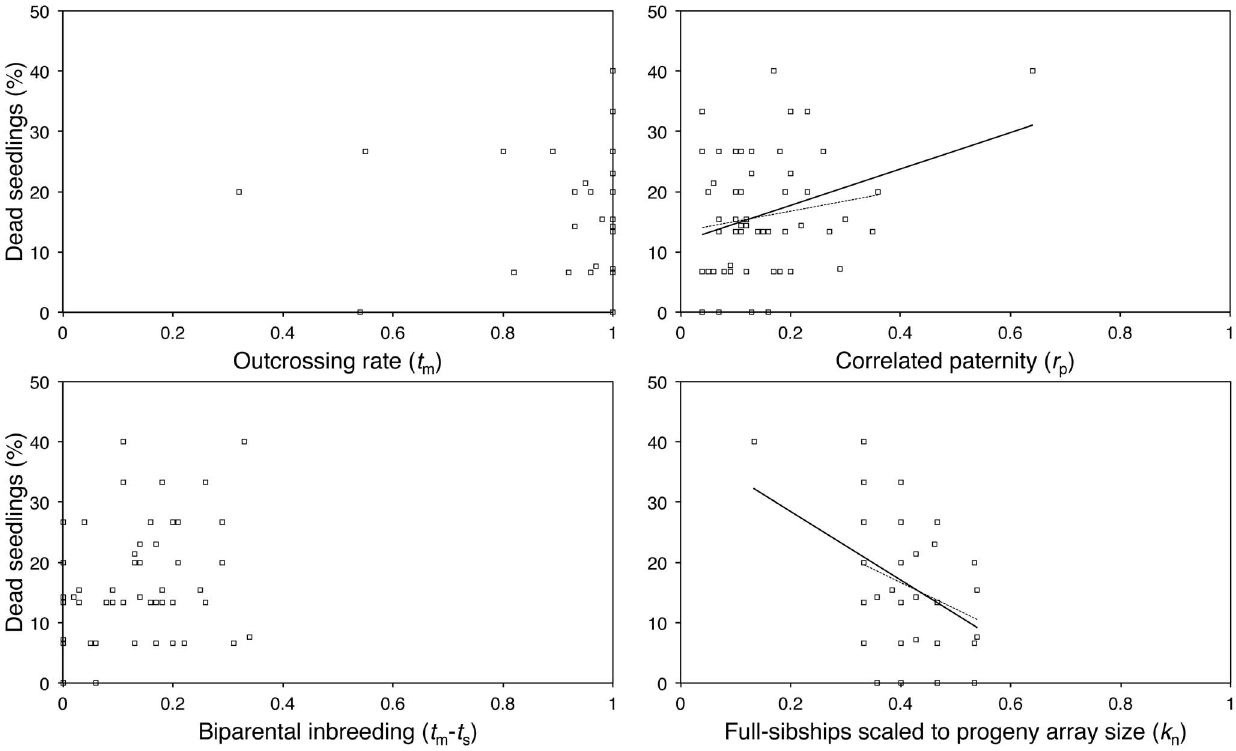
Figure 2. Scatterplots showing relationships between Eucalyptus gracilis family-level establishment rates and mating system parameters. Establishment rate percentages per progeny array are shown on the y-axis and mating system parameter values shown on the x-axis. Linear trend lines between genetic parameters and growth shown for relationships where D AIC c , 4 ( D AIC c values presented in Table 3). Trend lines are for all data are solid and trend lines are for data without the outlier are dashed.